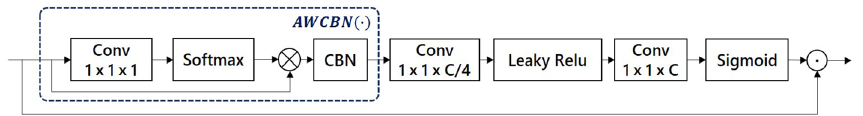
Figure 3. Network framework of adaptive weighted conditional batch normalisation attention module (AWCBNA).